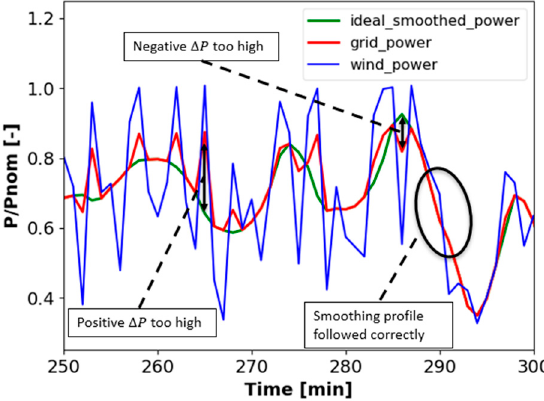
Figure 11. Example of turbine power output modified by battery constraints. Table 4. Algorithm correction to account for battery constraints.